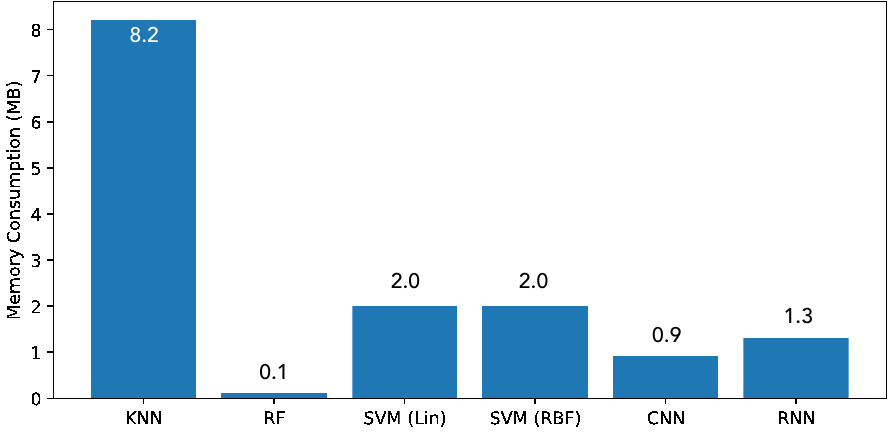
Figure 12. Memory consumption in MB for each of the best